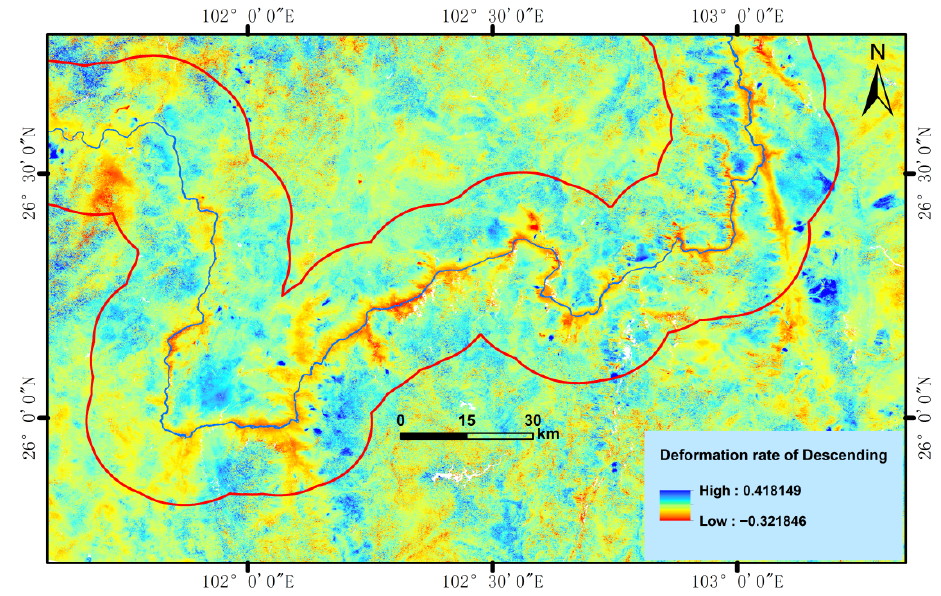
Figure 2. Deformation Results of the Ascending Orbit.